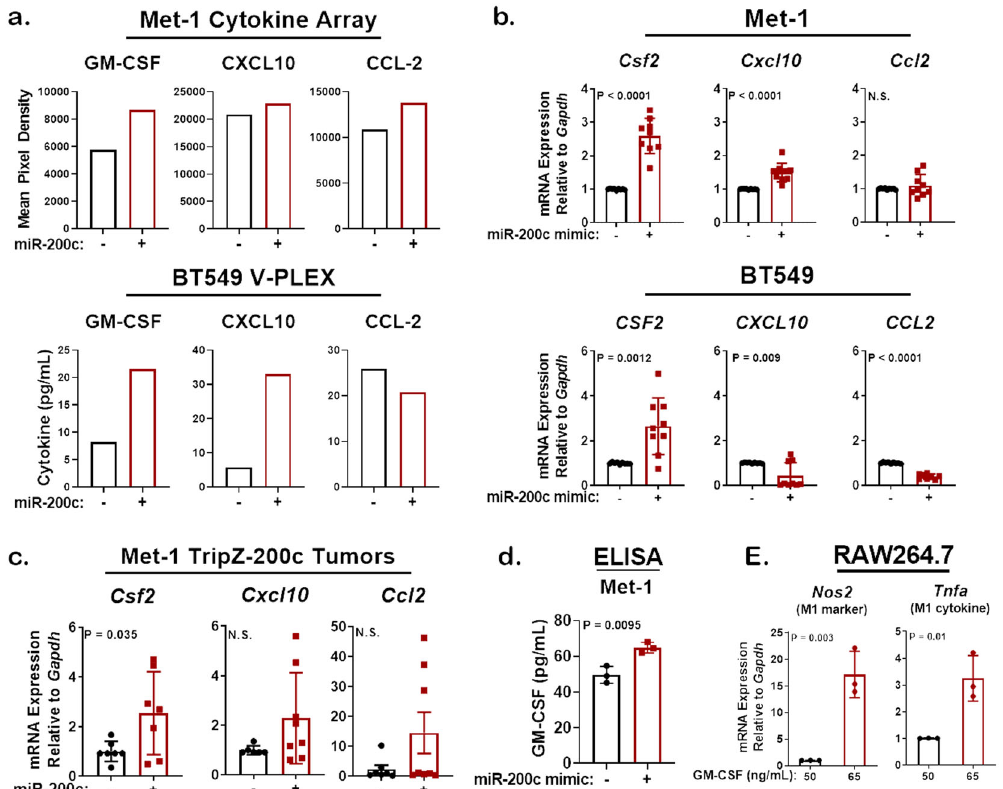
Fig. 3 MiR-200c restoration alters the pro fi le of cytokines secreted by aggressive mammary and breast carcinoma cells to favor those that enhance antitumor macrophage polarization. a A cytokine array was conducted on Met-1 TripZ-200c cell conditioned medium (CM; mouse) and a V-PLEX cytokine assay was conducted on BT549 TripZ-200c cell CM (human). Depicted are cytokines of interest that were altered in both models after miR-200c restoration and are known to promote monocyte in fi ltration, activation, or differentiation. b Met-1 (top) and BT549 (bottom) cells were harvested after 96 and 48 h, respectively, transient miR-200c restoration. qRT-PCR was conducted for CSF2 (GM-CSF), CXCL10 , and CCL2 , mean mRNA expression relative to GAPDH for 3 experiments conducted in triplicate ± s.d., N = 8 – 9, Student ’ s unpaired two- tailed t test. c qRT-PCR was conducted on Met-1 TripZ-200c tumors from Fig. 2d that were treated ± Dox for 24 to 30 days. Shown is the mean mRNA expression relative to Gapdh ± s.e.m, N = 6 – 8, Students unpaired two-tailed t test. d GM-CSF expression was observed in the CM of Met- 1 cells after miR-200c restoration for 96 h via transient transfection. Shown is the mean cytokine expression (pg/mL) for three experiments completed in triplicate ± s.d., N = 9, Students unpaired two-tailed t test. e RAW264.7 macrophages were treated with 50 ng/mL or 65 ng/mL GM-CSF for 48 h. Cells were harvested for mRNA extraction via TRIzol and macrophage polarization was determined via qRT-PCR for an M1 gene Nos2 (nitric oxide synthase/iNOS) and a cytokine secreted by M1 macrophages Tnfa (tumor necrosis factor- α , TNF α ). Representative mean mRNA expression relative to Gapdh for one experiment of three ± s.d., N = 3, Student ’ s unpaired two-tailed t